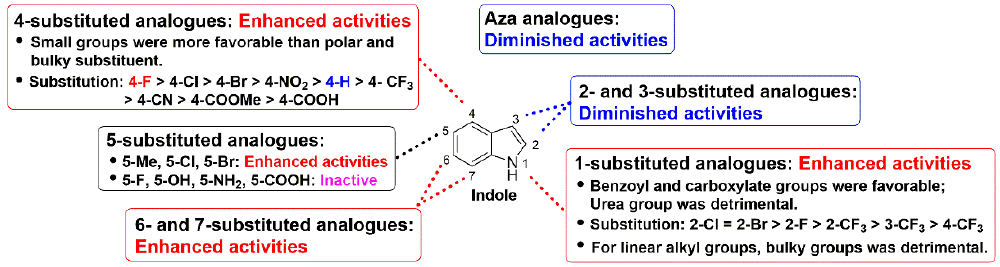
Figure 2. Detailed structure-activity relationships of indole compounds against R. solani